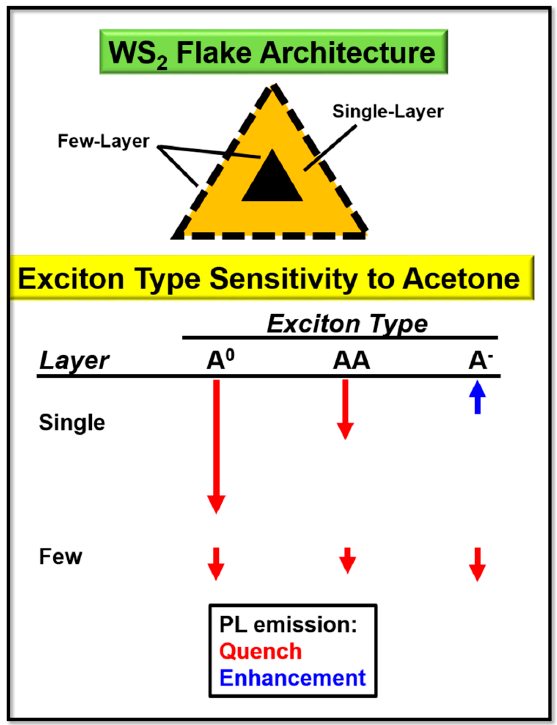
Figure 10. Model of the overall effect of acetone on exciton bands. A WS 2 flake in an air environment denoting single- and few-layer areas. The red arrows indicate a quench in PL and the blue arrow indicates an enhancement. The arrow length represents the effect magnitude.